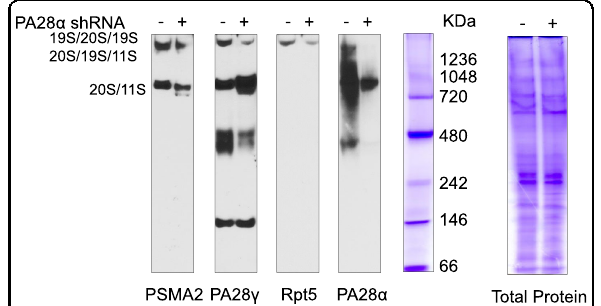
Fig. 6 Downregulation of PA28 α changes proteasome complex formation. LP1 PA28 α knockdown and control stable cells were lysed in proteasome lysis buffer, same amounts of cell lysates were loaded on native PAGE, and proteasome complex was checked followed by western blot. Total protein was also visualized by Coomassie Blue R- 250